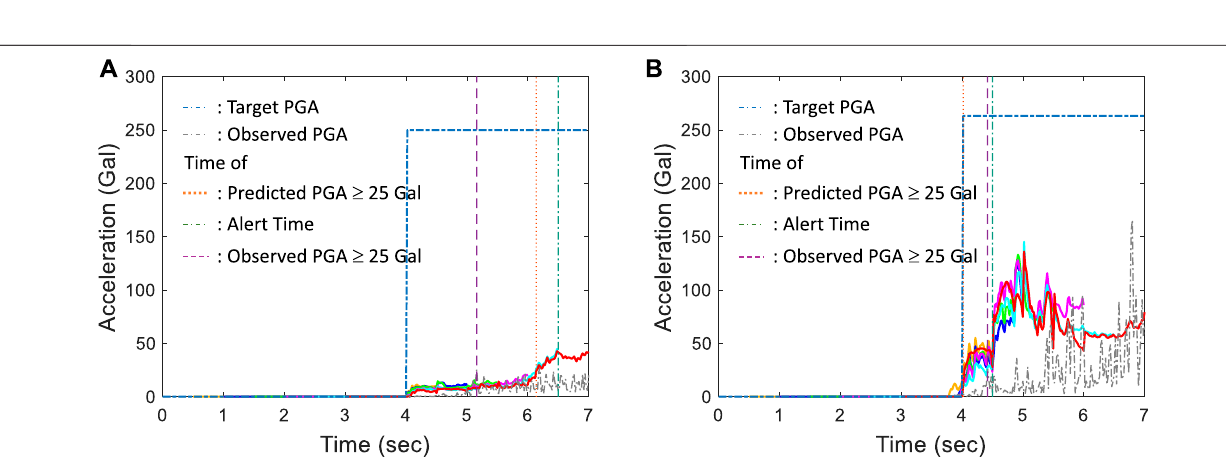
Frontiers in Earth Science |